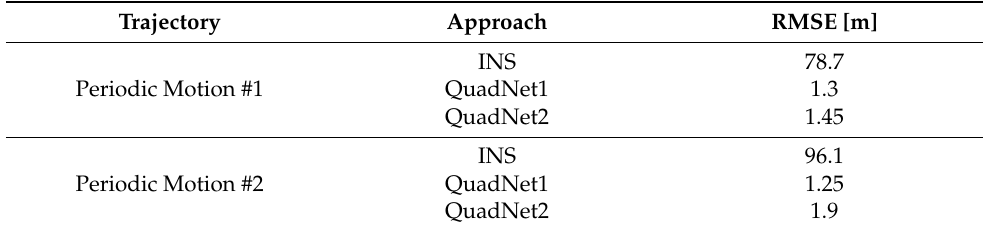
Table 4. INS and QuadNet height RMSE using IMU #2